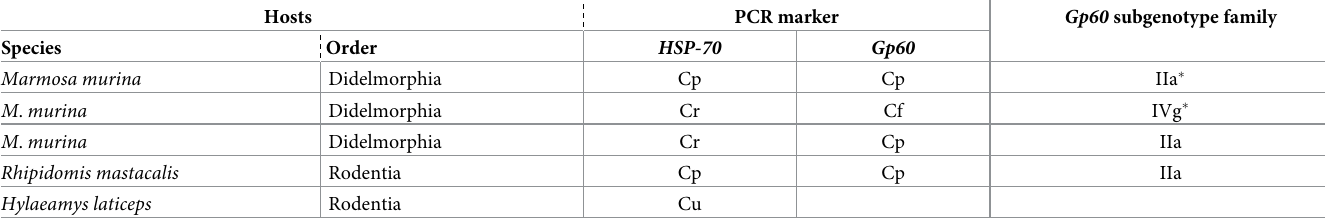
Table 3. Species of Cryptosporidium per parasitized host caught in forest and Cabruca area in southern Bahia, northeastern